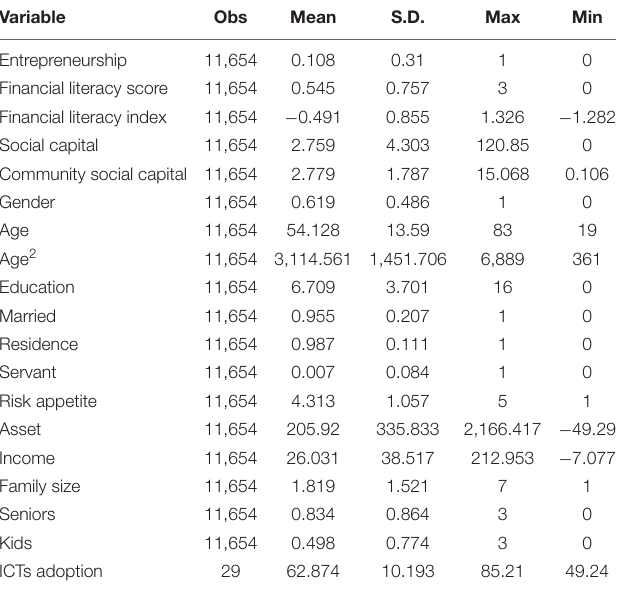
TABLE 4 | Descriptive statistics of the